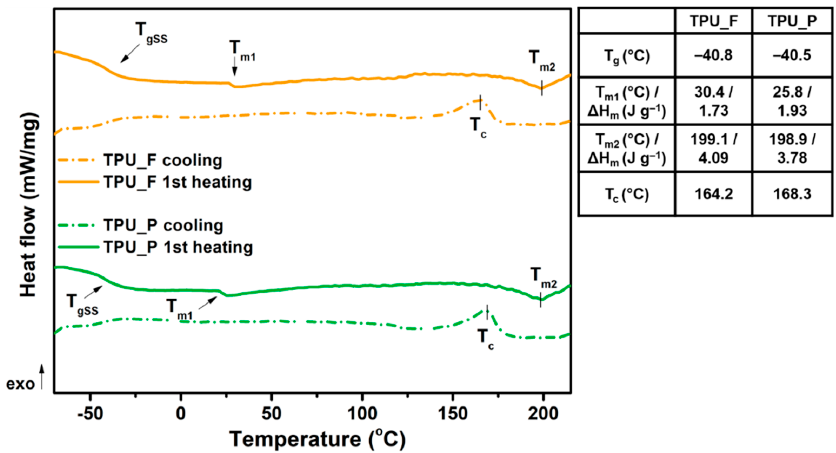
Figure 4. Differential scanning calorimetry DSC curves of obtained TPU filament and printout (1st heating and cooling cycle).